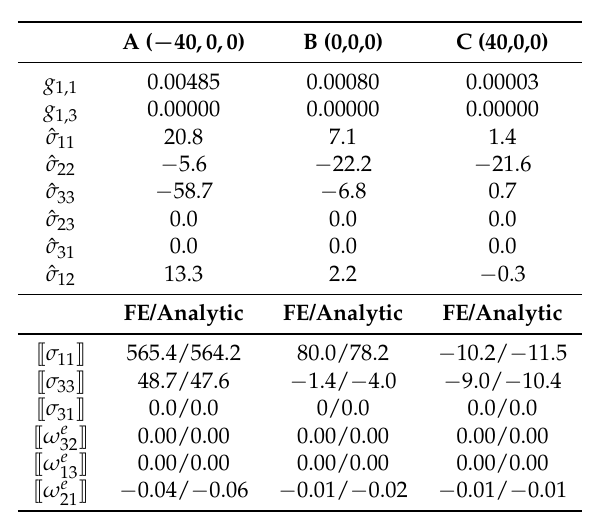
Table 3. Values of ˆ σ (MPa) and ∇ g provided by the FE simulation 3 and used to compute the analytic ∼ formulas (28)–(30) and (32) (top). Comparisons of the values of [[ σ simulation 3 and those computed from the analytic formulas (bottom).